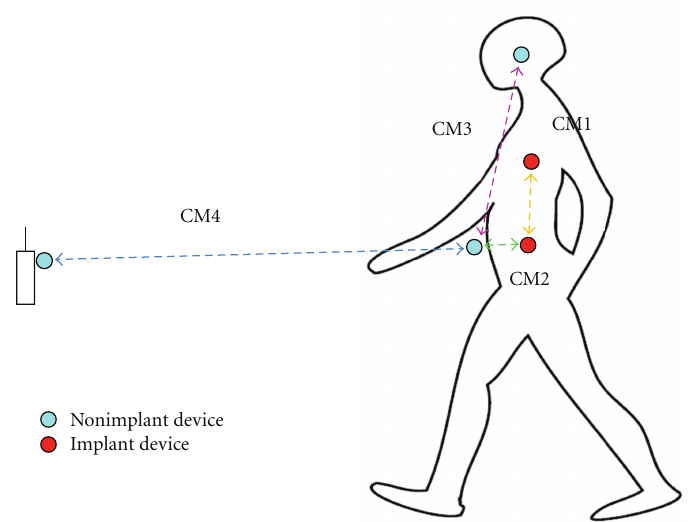
Figure 1: Possible communication links for WBAN.